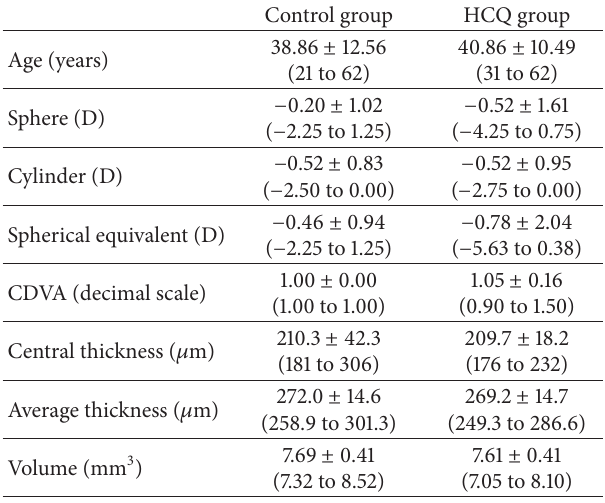
Table 1: Clinical characteristics of the two groups of the analyzed